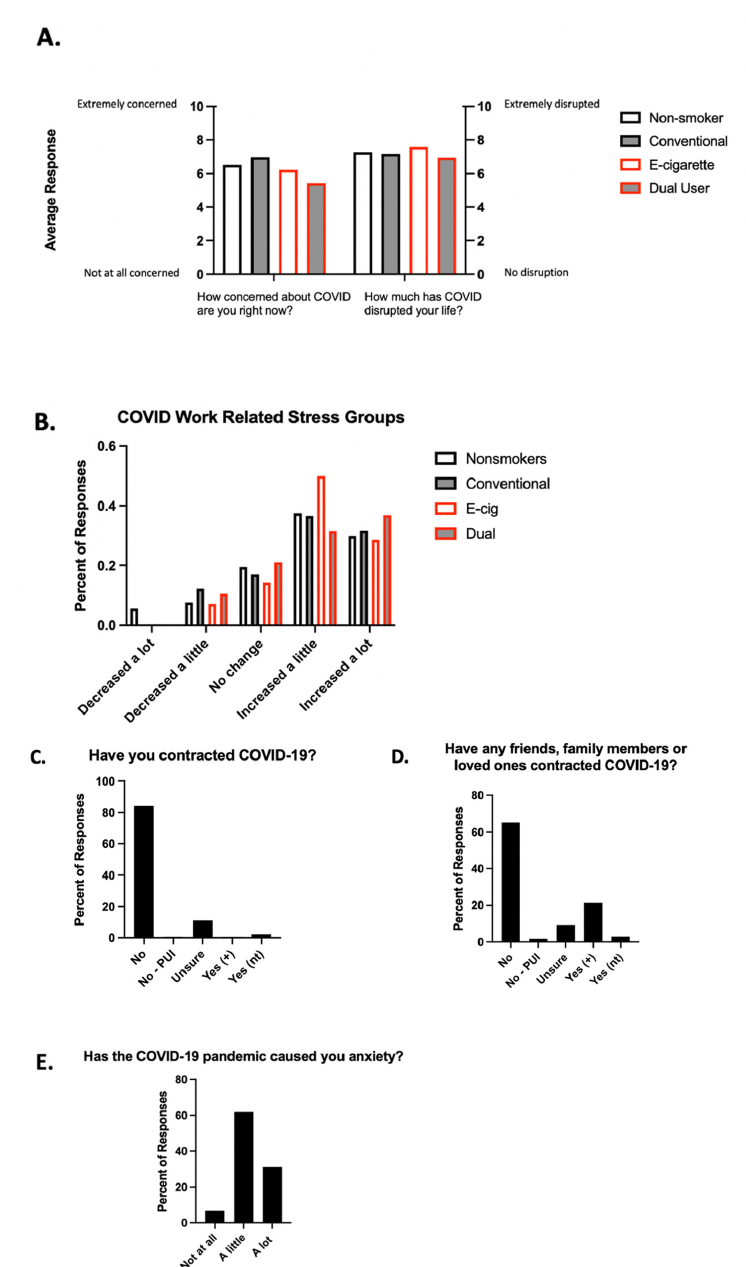
Figure 3. Non-inhalant and inhalant users experienced anxiety and work-related stress during the COVID pandemic. ( A ) Responses to “How concerned about COVID are you right now?” and “How much has COVID disrupted your life?” Answers were submitted free response to these questions on a scale from 1–10. Average responses for the entire group of participants are presented. ( B ) Assessment of work-related stress caused by the pandemic across inhalant groups. Participants responded by selecting one of the multiple-choice options: decreased a lot, decreased a little, no change, increased a little, increased a lot. ( C , D ) Rates of COVID-19 in survey responders and their loved ones, expressed as percent of total responses. Answer options were the following: no; no but was a person under investigation (No–PUI); unsure; yes and tested positive (Yes (+)); and yes but was not tested (Yes (nt)). ( E ) Assessment of anxiety caused by the COVID-19 pandemic, expressed as percent of total responses. Answer options included not at all, a little, and a